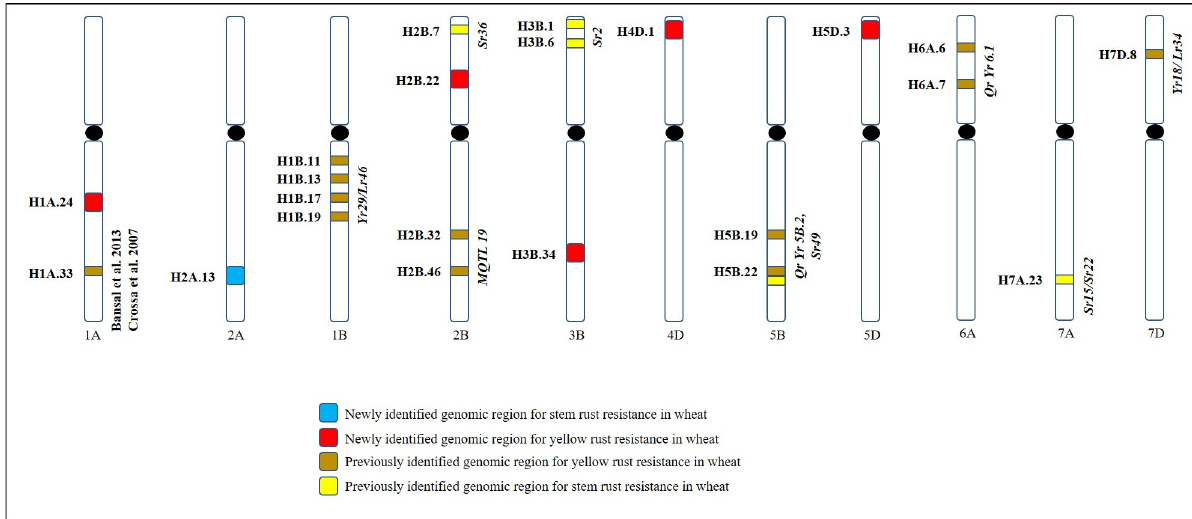
Fig 8. Figure presenting location of haplotype block–trait association on wheat hromosoe arms. Novel and previously identified genomic regions have been pictorially depicted in the figure.